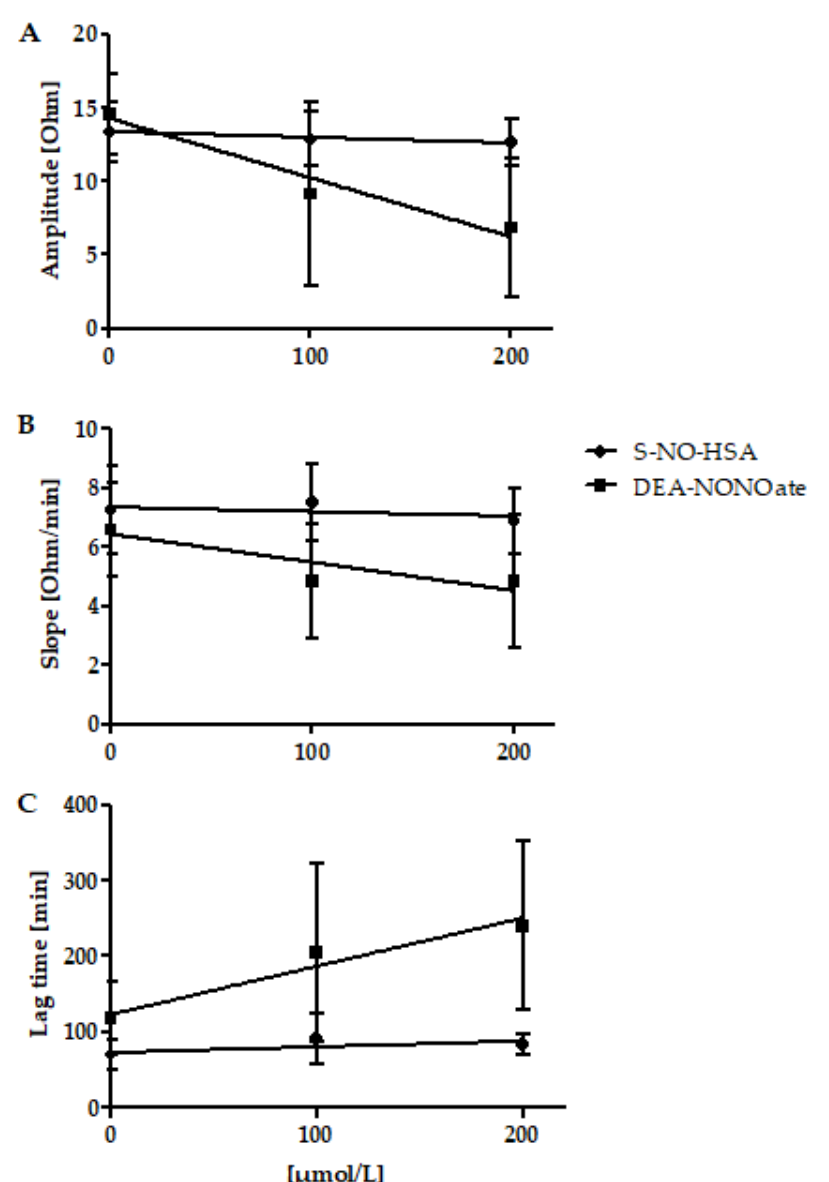
Figure 2. Effects of increasing concentrations of S-NO-HSA or DEA-NONOate on impedance aggregometry values in WB. Panel ( A ): Addition of S-NO-HSA had no effect on amplitudes, while the addition of equimolar amounts of DEA-NONOate led to decreased amplitudes. Linear regression analysis showed that slopes differed significantly (p = 0.0009. Panel ( B ): Addition of S-NO-HSA had no influence on Slopes while the addition of equimolar amounts of DEA-NONOate caused a dose-dependent decrease of Slopes. Linear regression analysis showed that slopes differ significantly ( p = 0.0009). Panel ( C ): Addition of S-NO-HSA had no effect on Lag times, while the addition of equimolar amounts of DEA-NONOate led to prolonged lag times. Linear regression analysis showed that the slopes differ significantly ( p = 0.0061). The results are presented as mean ± SD; n = 16 (S-NO-HSA), n = 13 (DEA-NONOate). The data at 0 µ mol/L represent the values of the appropriate controls (no NO-donor